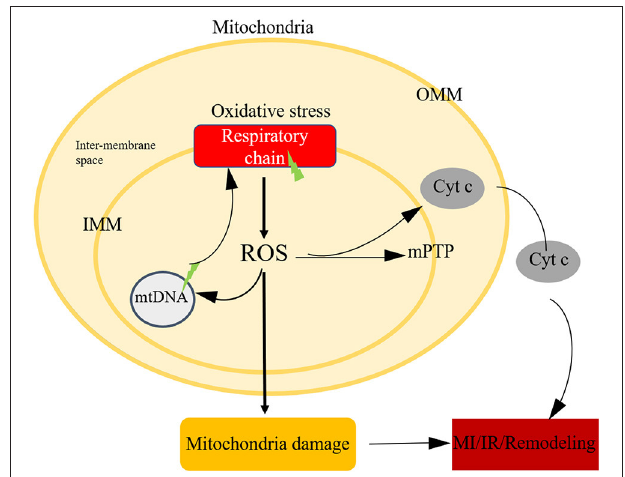
FIGURE 4 | Mitochondria oxidative stress in ischemic heart disease. Mitochondria is the main source of ROS, after oxidative stress, the respiratory chain could generate ROS, the imbalance level of ROS could attribute to mtDNA damage, initiate the open of mPTP, leading to cell